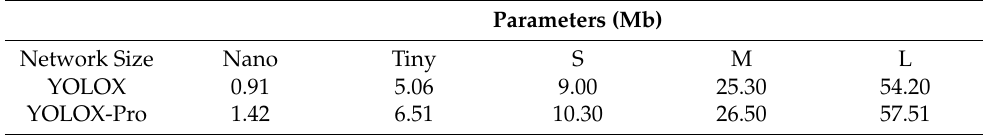
Table 2. The Parameters of YOLOX and